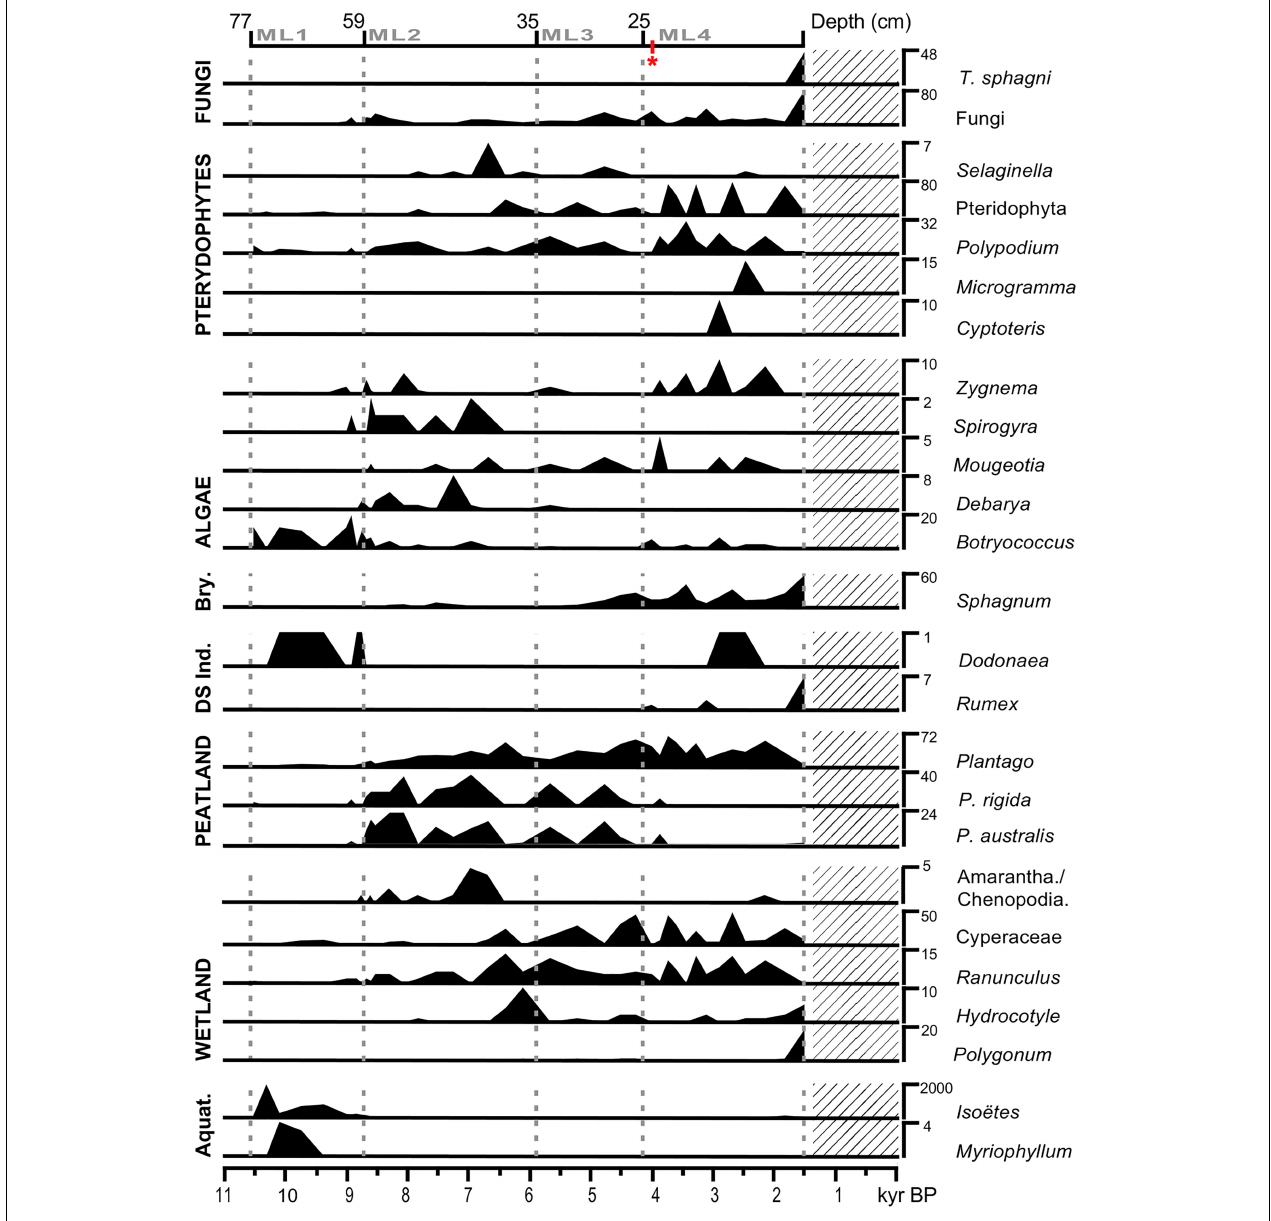
FIGURE 4 | Summary pollen diagram of MAR19-II core from Monquentiva showing local taxa organized by vegetation groups and presented as counts. Dashed gray lines indicate the limits for local pollen zones ML1 to ML4 from the CONISS zonation. The lattice denotes a gap in the MAR19-II sedimentary record. The red * indicates one sample where the pollen count was below 300 grains and reached 258 grains. Bry., Bryophites; DS Ind., Disturbance Indicator; Aquat., Aquatic